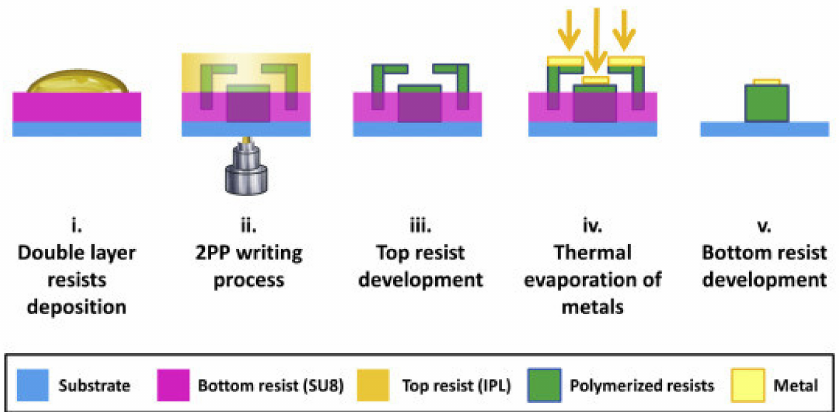
Figure 11. Schematic illustration of localized metallization using a sacrificial stencil mask. Repro- duced with permission from Ref. [110] Copyright 2019